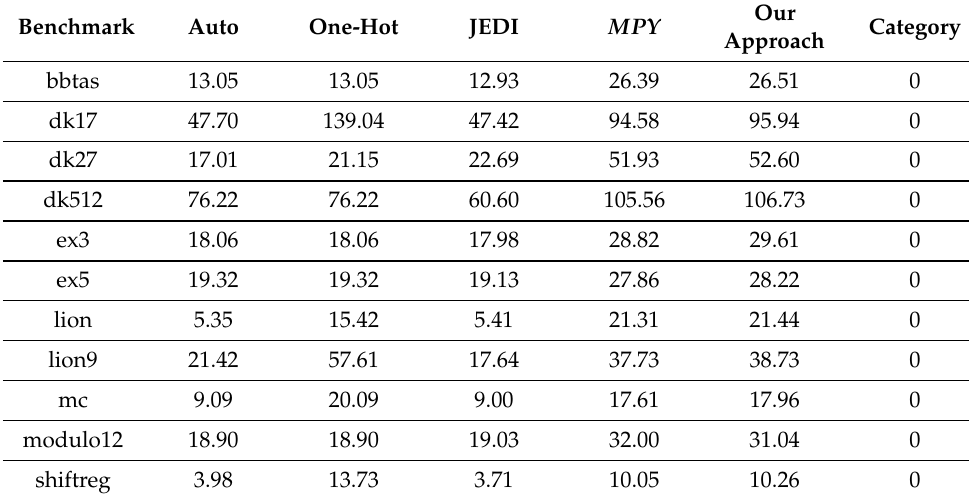
Table 12. Experimental results (area-time-power products)